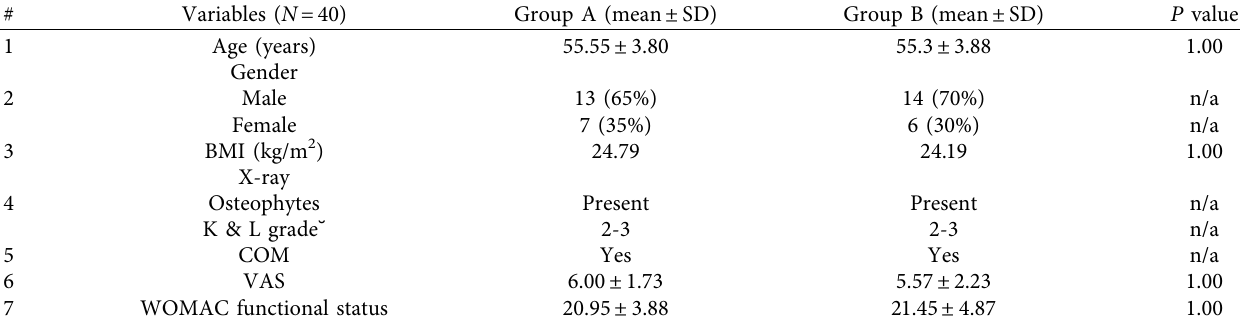
Table 1: Demographic characteristics and baseline scores of all variables for all the participants ( N �